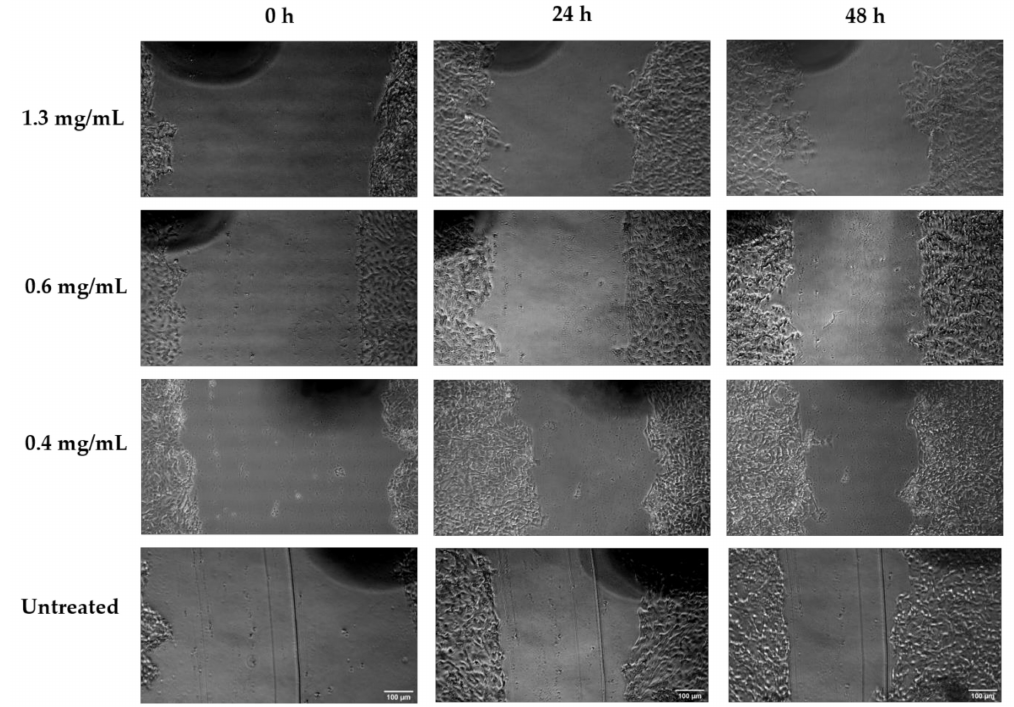
Figure 5. Microscopic photos of wound gaps in HaCaT cells introduced by the scratch technique after treatment with Aloe muth-muth whole leaf material at 1.3 mg / mL, 0.6 mg / mL, and 0.4 mg / mL, compared to an untreated control, at 0 h, 24 h, and 48 h. Images were captured at 10 × magnification and the scale bars indicate 100 µ